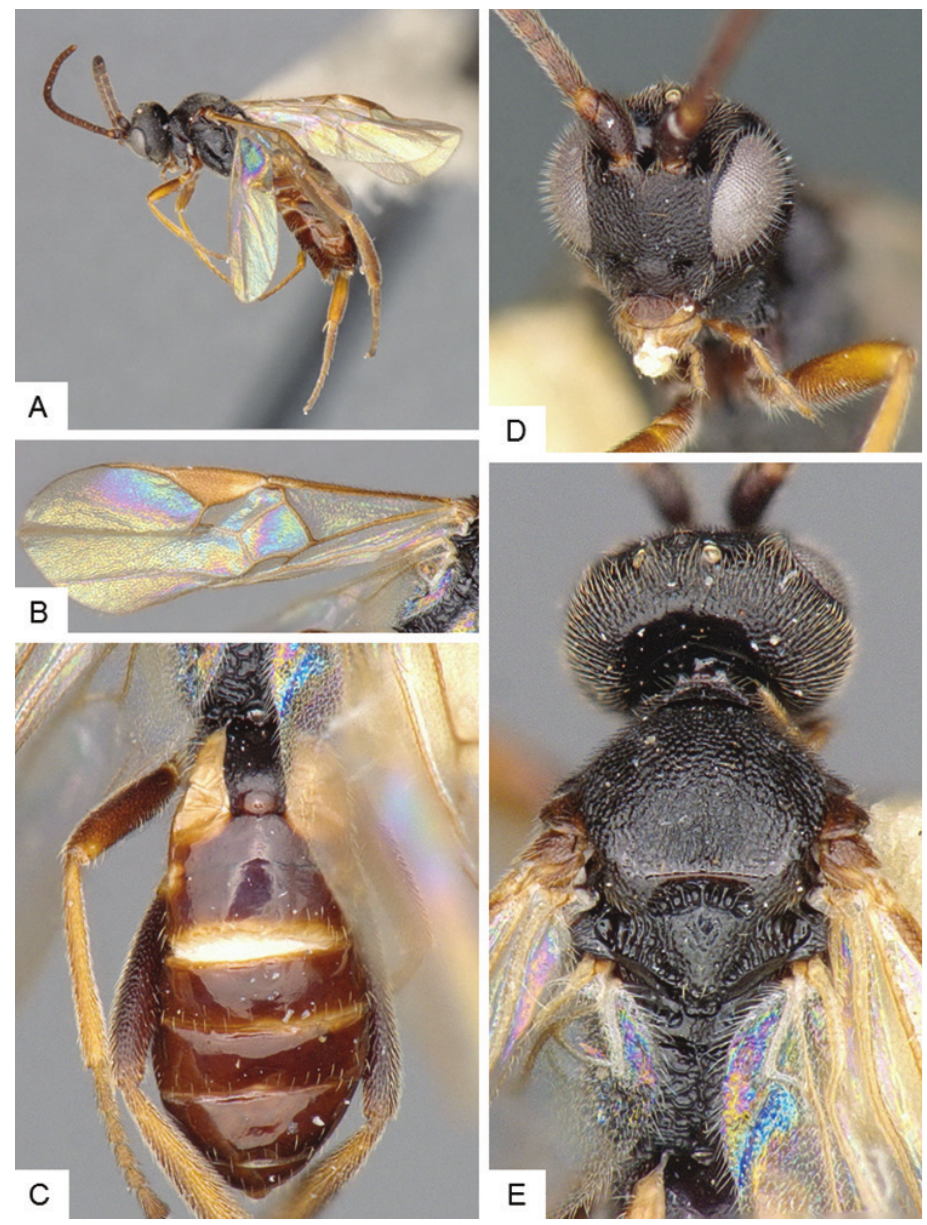
Figure 24. Microplitis coactus . A Habitus, lateral B Fore wing C Metasoma, dorsal D Head, dorsal E Head and mesosoma,